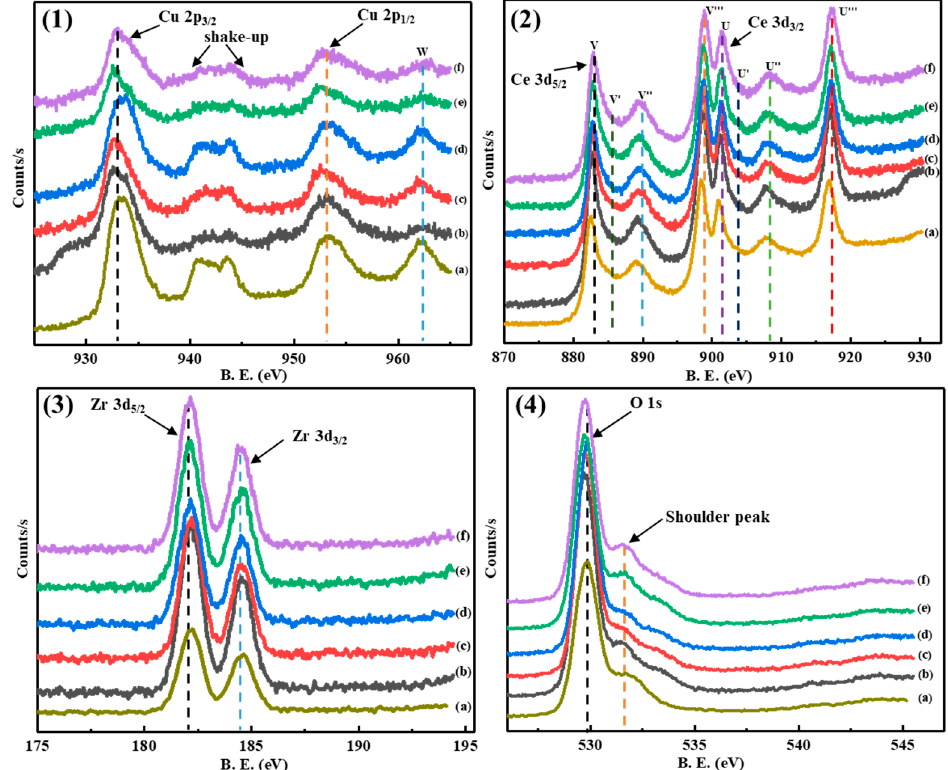
Figure 7. XPS spectra of Cu 2p ( 1 ), Ce 3d ( 2 ), Zr 3d ( 3 ), and O 1s ( 4 ) for 15CuO/M-Ce80Zr20 and15CuO- 3MO x /M-Ce80Zr20 (MO x = La 2 O 3 , Fe 2 O 3 , PrO 2 , Sm 2 O 3 , MnO 2 ) catalysts: ( a ) 15CuO/M-Ce80Zr20, ( b )